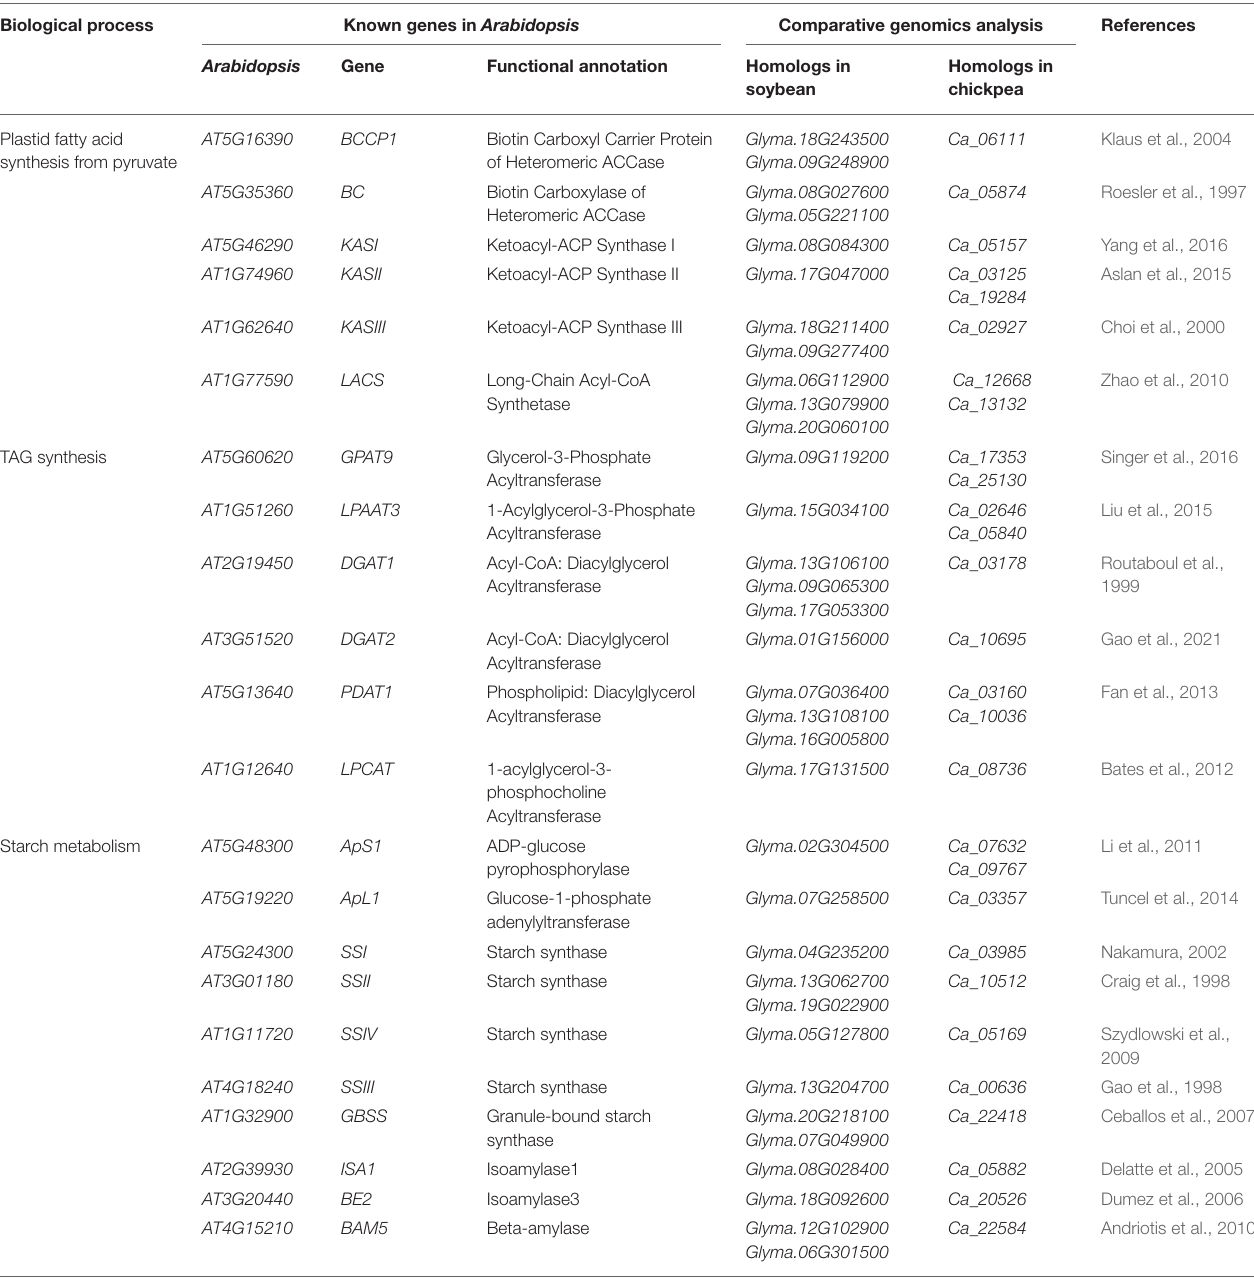
TABLE 1 | The confirmed candidate genes for the differences of soybean and chickpea seed oil and starch content in previous